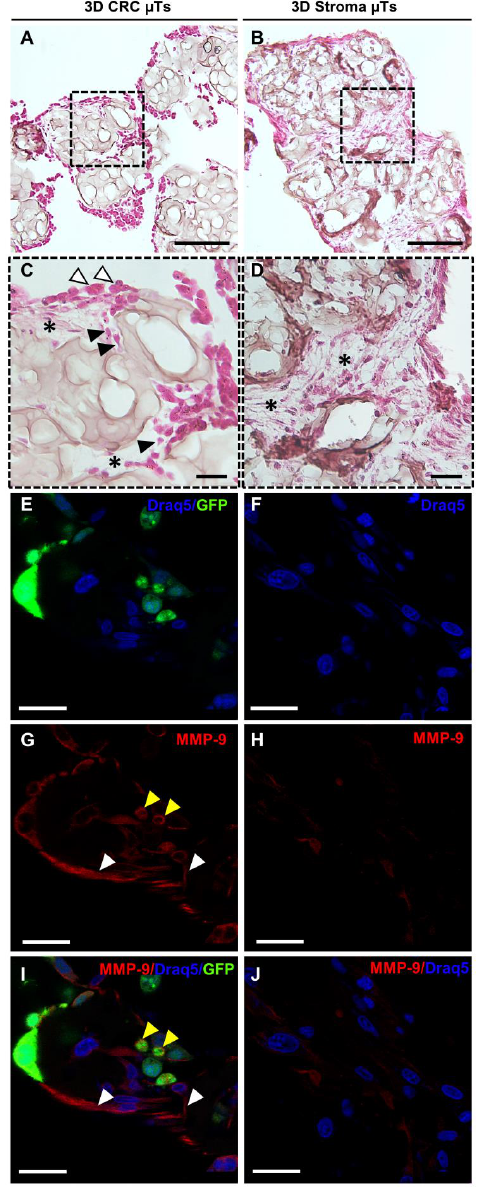
Figure 6. Extracellular Matrix (ECM) remodeling in the 3D CRC µ Ts and the 3D Stroma µ Ts at day 12 of culturing. ( A , B ) Histological section of the 3D CRC µ Ts and the 3D Stroma µ Ts, respectively, stained with H&E; scale bar: 100 µ m. ( C , D ) Histological insets of the 3D CRC µ Ts and the 3D Stroma µ Ts with the presence of automatically produced ECM (indicated with asterisks), respectively, and I morphological changes in the HCT-116 cells, indicated by the white (round shape) and black (spindle shape) arrows; scale bar: 30 µ m. ( E , G , I ) and ( F , H , J ): Immunofluorescence staining of the 3D CRC µ Ts (HCT-116 cells and fibroblasts indicated by yellow and white arrows, respectively) and the 3D Stroma µ Ts; scale bar: 50 µ m. Nuclear staining with Draq5 (blue), green fluorescent protein (GFP) signal of HCT-116 cells (green), and Matrix metalloproteinase-9 (MMP-9) signal